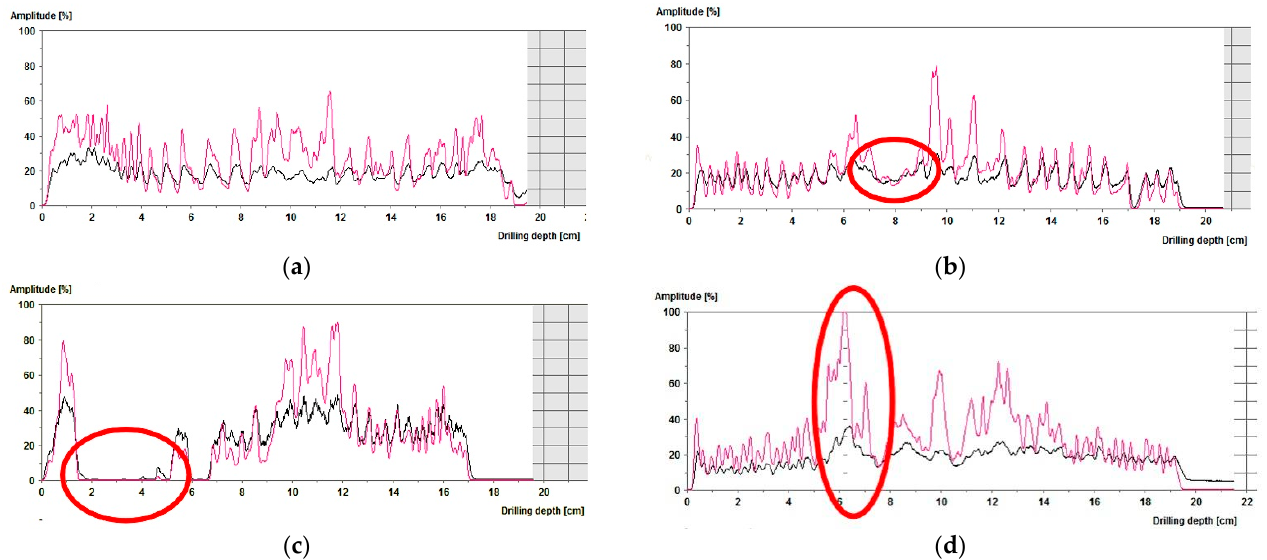
Figure 7. Method for judging micro-drill resistance maps; ( a ) map with good internal structure; ( b ) map with internal decay; ( c ) map with internal hollows or cracks; ( d ) map with internal knots.